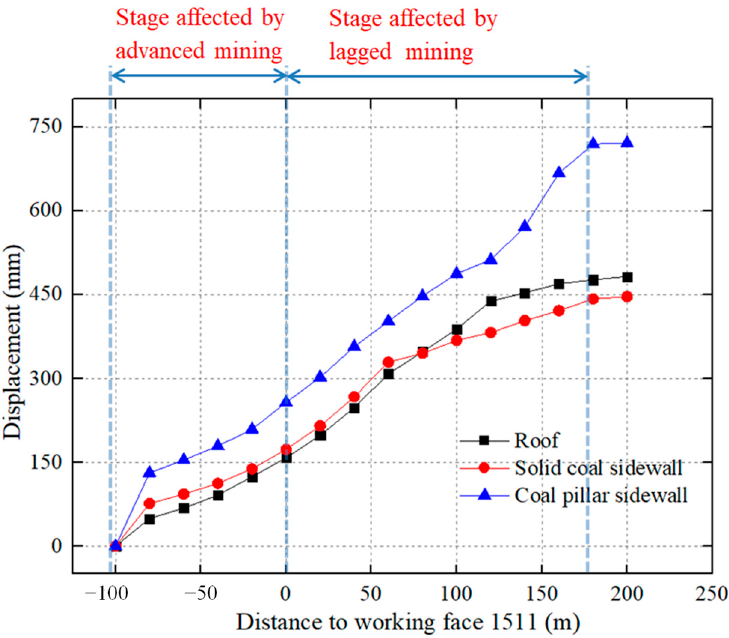
Figure 13. Surface displacement law of surrounding rock in zone B of MTR 1513.